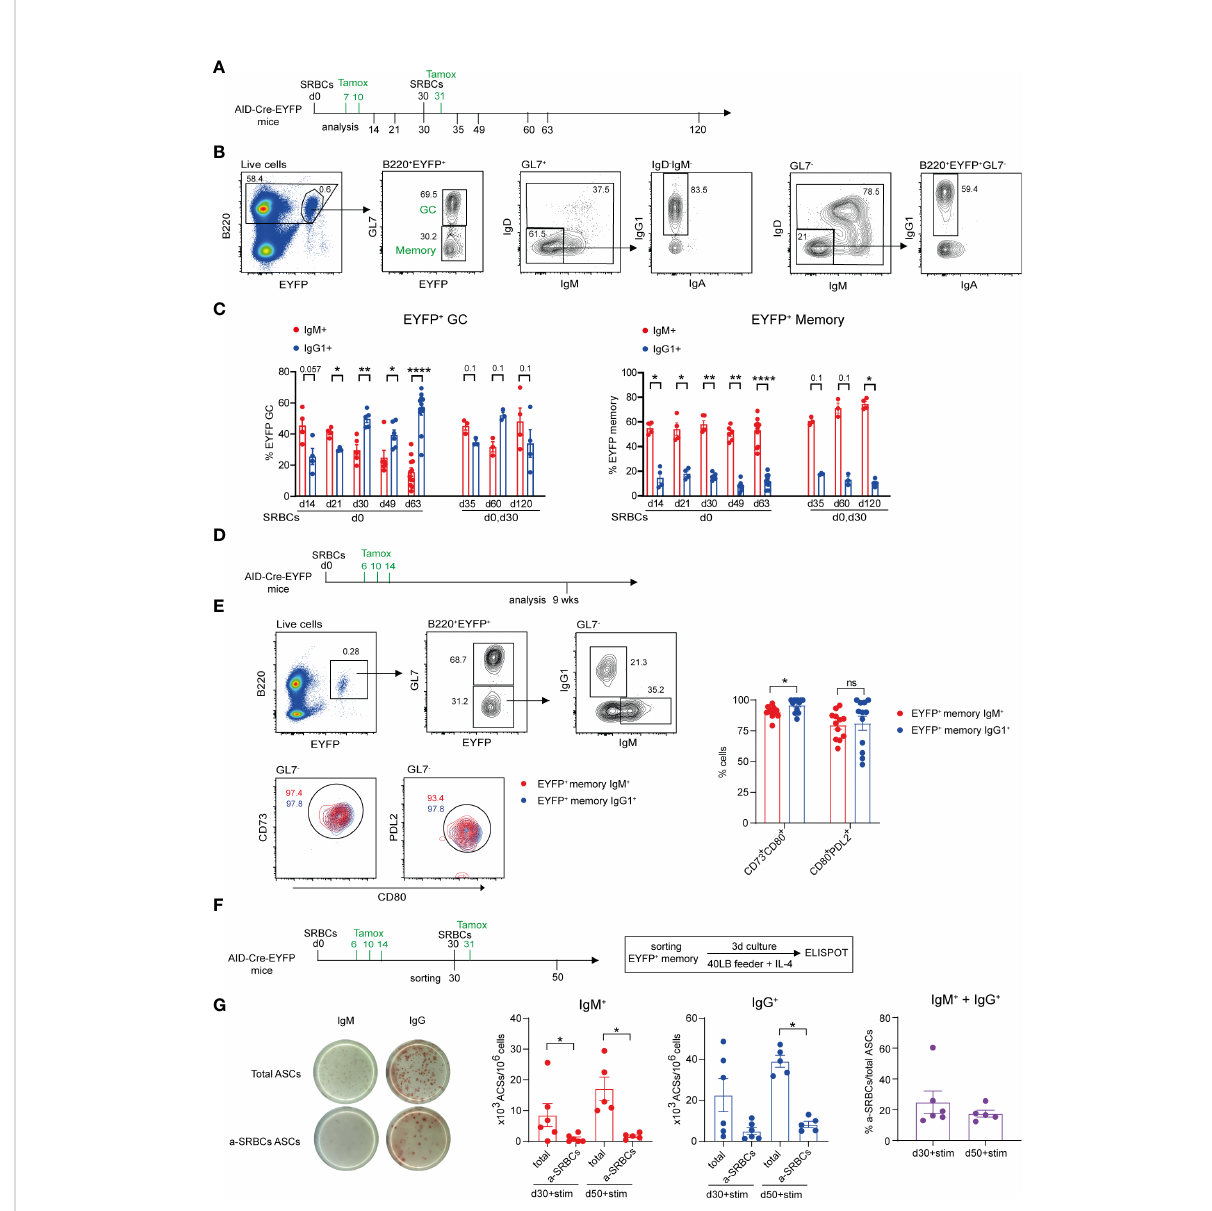
FIGURE 1 Characteristics of the GC and memory response after SRBC immunization. (A) AID-Cre-EYFP mice were primed i.p. with SRBCs and, where indicated, received boost injections on day 30. Tamoxifen was administrated on d7,10 and 31 (when a boost on d30 was performed). Analyses were done on splenocytes at different time points: d14, 21, 30, 35, 49, 60, 63, 120. (B) Representative fl ow cytometry gating strategy to identify GL7 + GC and GL7 - MBCs among B220 + EYFP + cells and IgM/IgD, IgG1 vs. IgA isotype subclass distribution. (C) Distribution of EYFP + GC (on the left) and MBCs (on the right) between IgM and IgG1 isotype expression. (D) AID-Cre-EYFP mice immunized with SRBCs received three doses of tamoxifen on d6,10,14. Spleens were analyzed 9 weeks after prime injection to characterize maturation markers expressed by EYFP + MBCs. (E) The expression of CD73, CD80 and PDL2 was assessed on EYFP + GL7 - IgM + and IgG1 + memory cells. A representative fl ow cytometry pro fi le is shown. Percentages of CD73 + CD80 + and PDL2 + CD80 + populations from IgM + and IgG1 + EYFP + memory subsets are shown in the scatter plot. (F) AID-Cre-EYFP mice received SRBC injection and tamoxifen gavage on d6,10,14. A group of mice was further boosted on d30 and tamoxifen fed the day after. EYFP + GL7 - PNA - memory cells sorted on d30 or d50 were cultured for 3 days on 3T3 40LB feeder cells in the presence of IL- 4 to induce plasma cell differentiation. To detect total and anti-SRBCs IgM + and IgG + antibody secreting cells (ASCs) an ELISPOT assay was conducted. (G) Representative ELISPOT images of IgM and IgG ASCs are shown on the left. IgM + and IgG + ASCs were counted and expressed as 10 3 ASCs among 10 6 plated cells. Percentages of IgM + IgG anti-SRBCs ASCs among total ASCs are shown in the far-right graph. Each point in the graphs represents an individual mouse. Panel (C) was assembled from independent experiments representing different immunization schedules, and at least two independent experiments were performed in panels (E, G) Means ( ± SEM) are shown. Mann Whitney test was used to compare the different conditions from panels (C, E, (G) Kruskal-Wallis analysis with uncorrected Dunn ’ s test was performed to compare the different conditions on the two graphs on the left in panel (G) p values>0.05 are indicated on panel (C) ; *p<0.05, **p<0.01, ****p<0.0001. ns=not statistically signi fi cant.